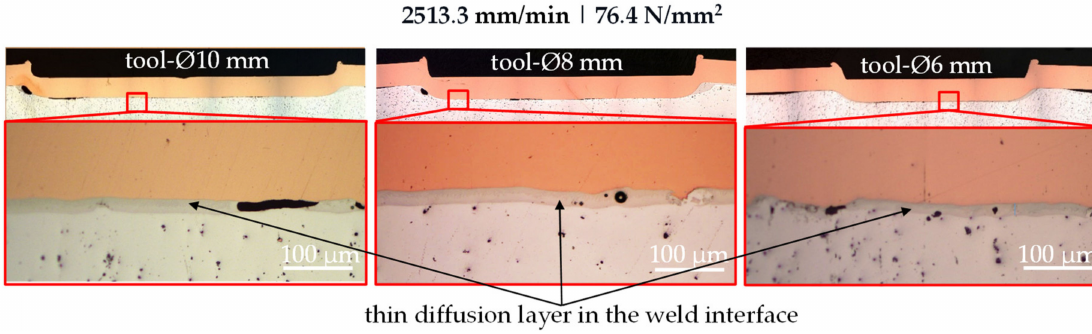
Figure 19. Microsections of joints welded with different tool